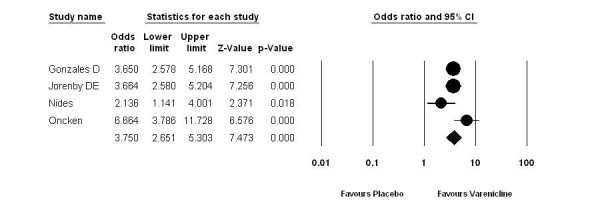
Random Effects Meta-Analysis. Varenicline vs. Placebo at 3 months. I2 = 57.7%.